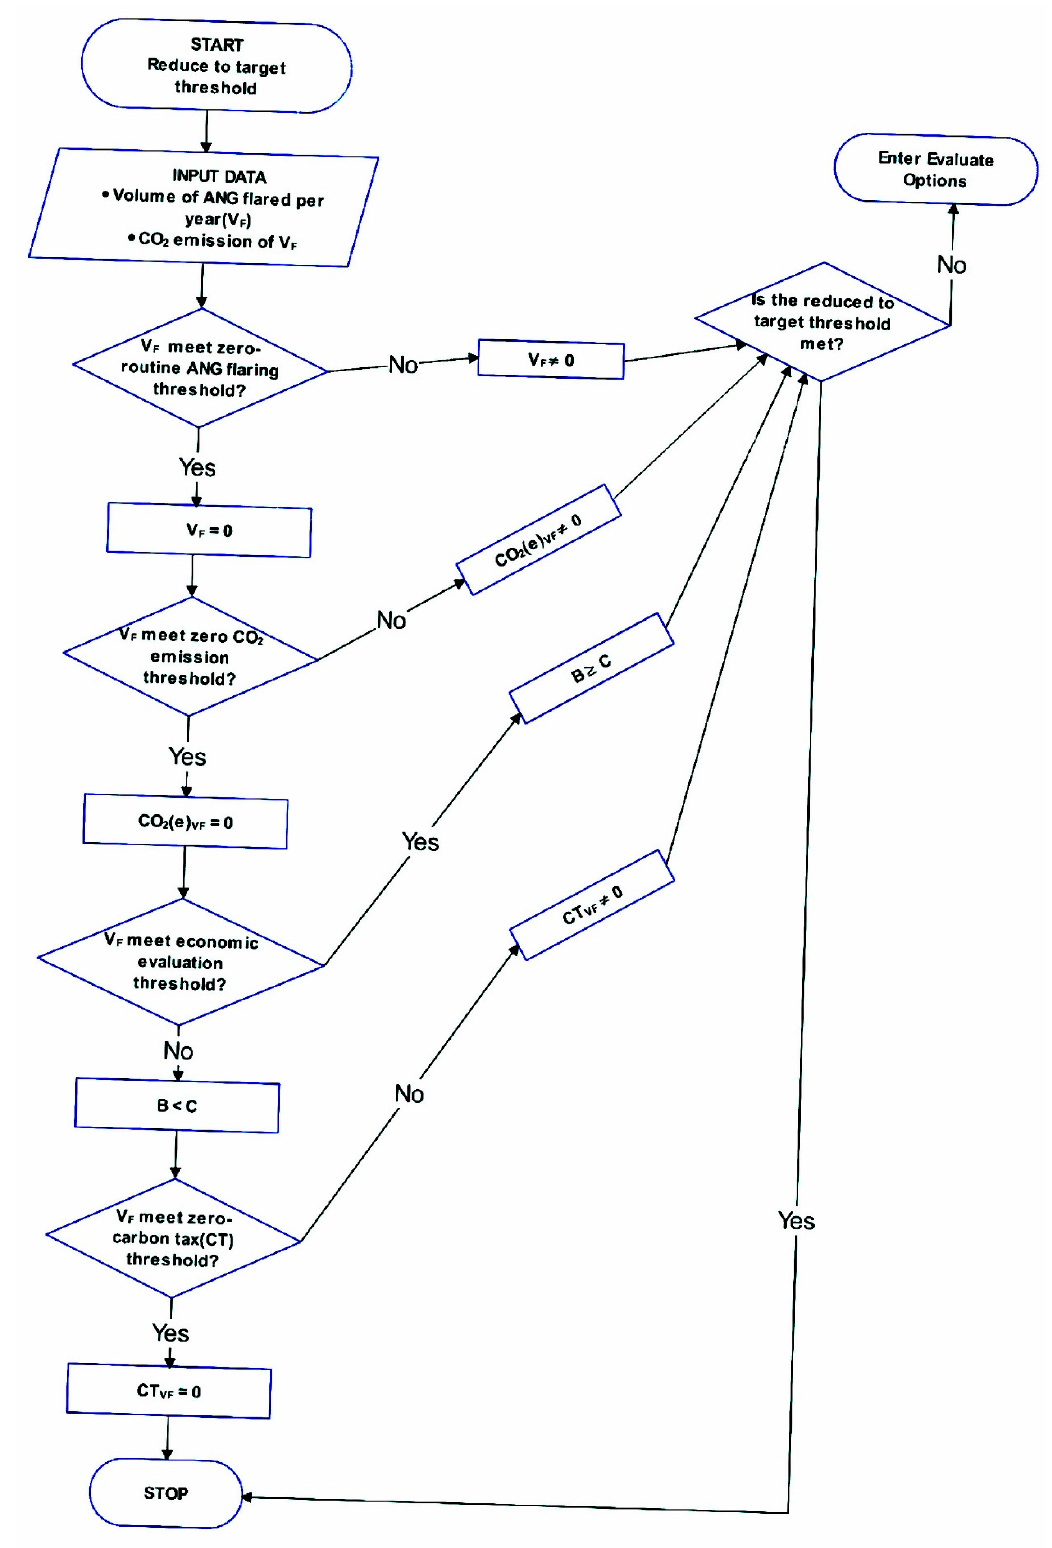
Figure 9. Reduce to Target Threshold flowchart.